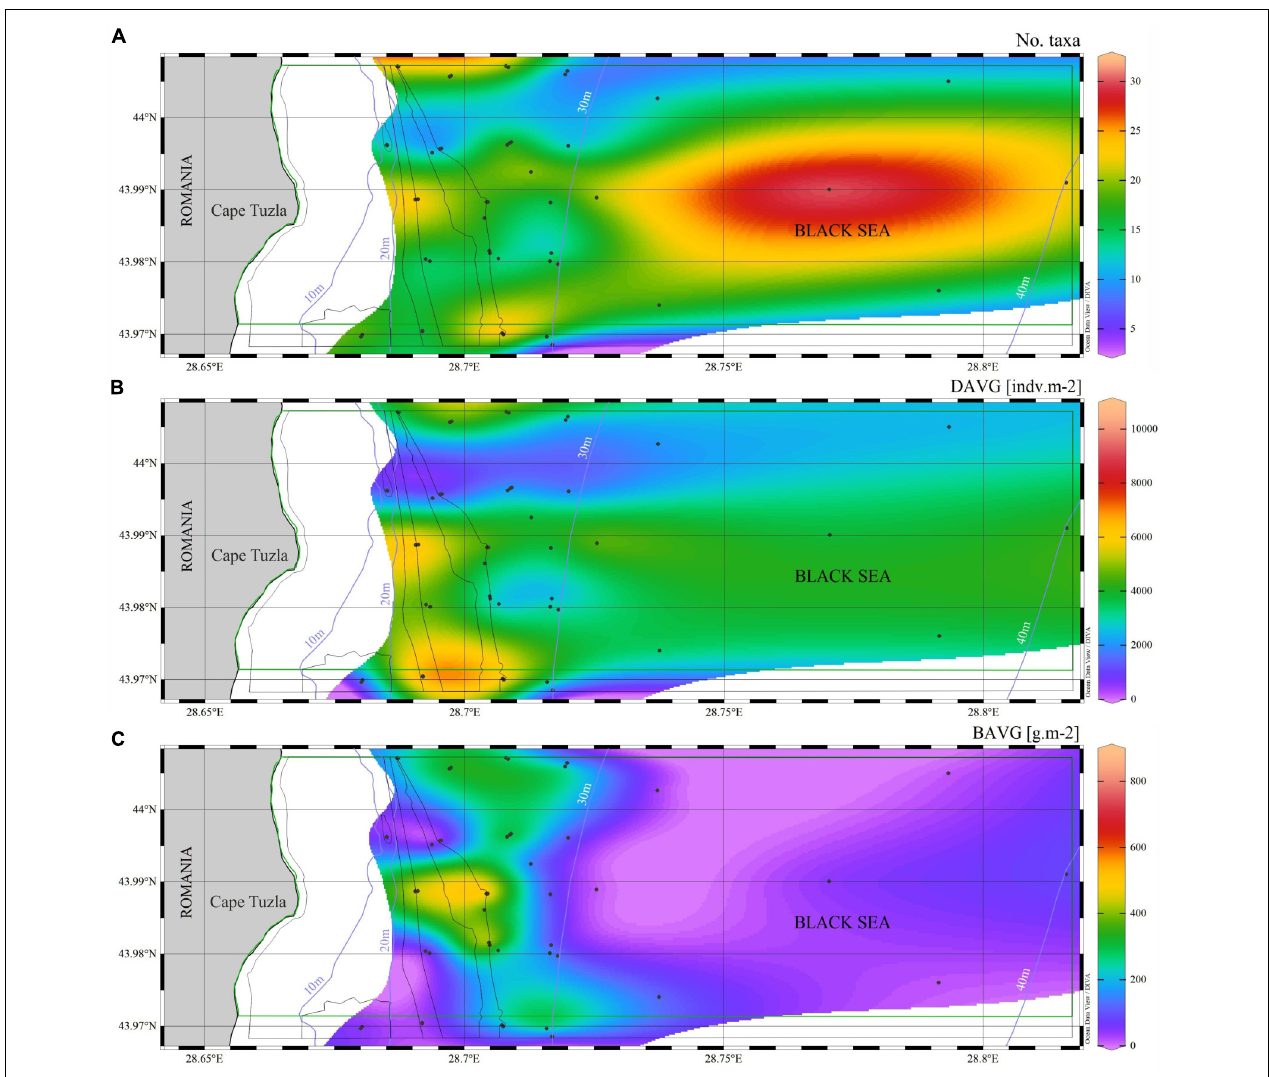
FIGURE 6 | Contour maps showing the variation in (A) the number of macrozoobenthic taxa, (B) their mean density and (C) mean biomass in the Cape Tuzla MPA, based on samples (round symbols) collected between 2012 and 2018.